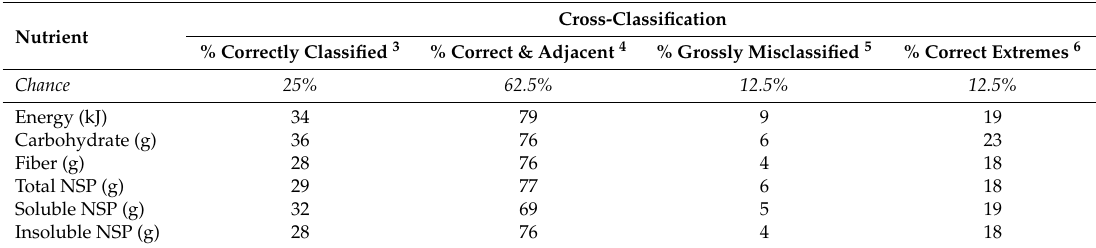
Table 3. Nutrient cross-classification between EAT5 FFQ and WDR quartiles in 5-year old children ( n = 100) 1,2 .